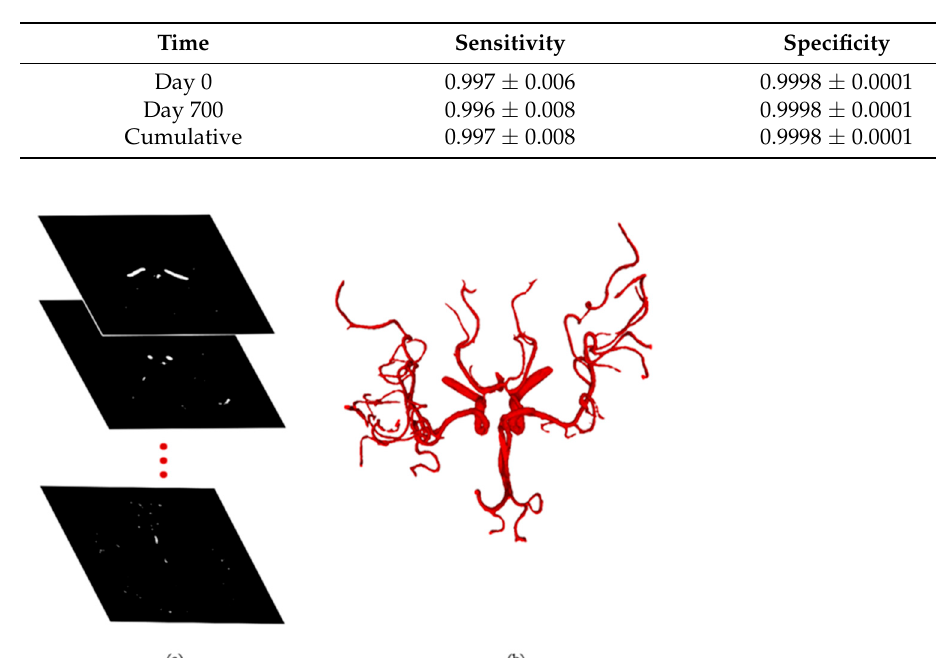
Table 1. Sensitivity and specificity values for automatically segmented images at day 0, day 700, and cumulative.